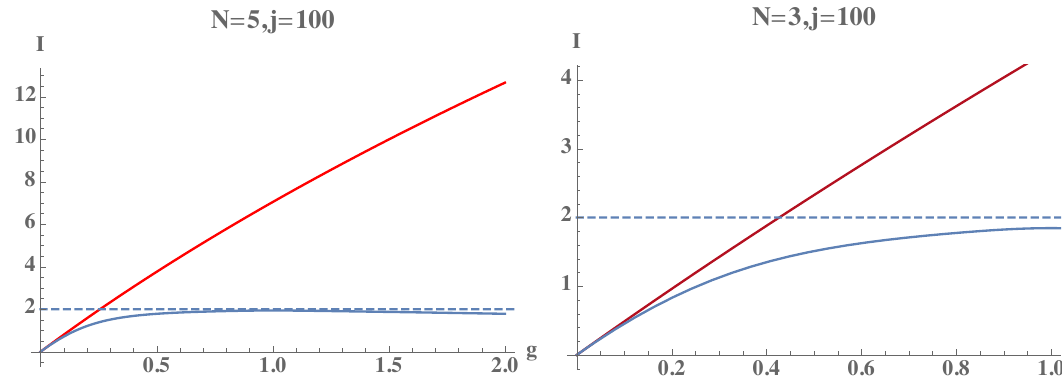
Figure 10. Dimensions of leading and subleading twist operators at (cid:12)nite values of N = 5 and N = 3. The crossing point is given by the intersection of the red curve (Pad(cid:19)e for (cid:12)nite spin twist- two) and the blue dashed curve (Pad(cid:18)e for twist-four). The solid blue line indicates the modular invariant interpolating function